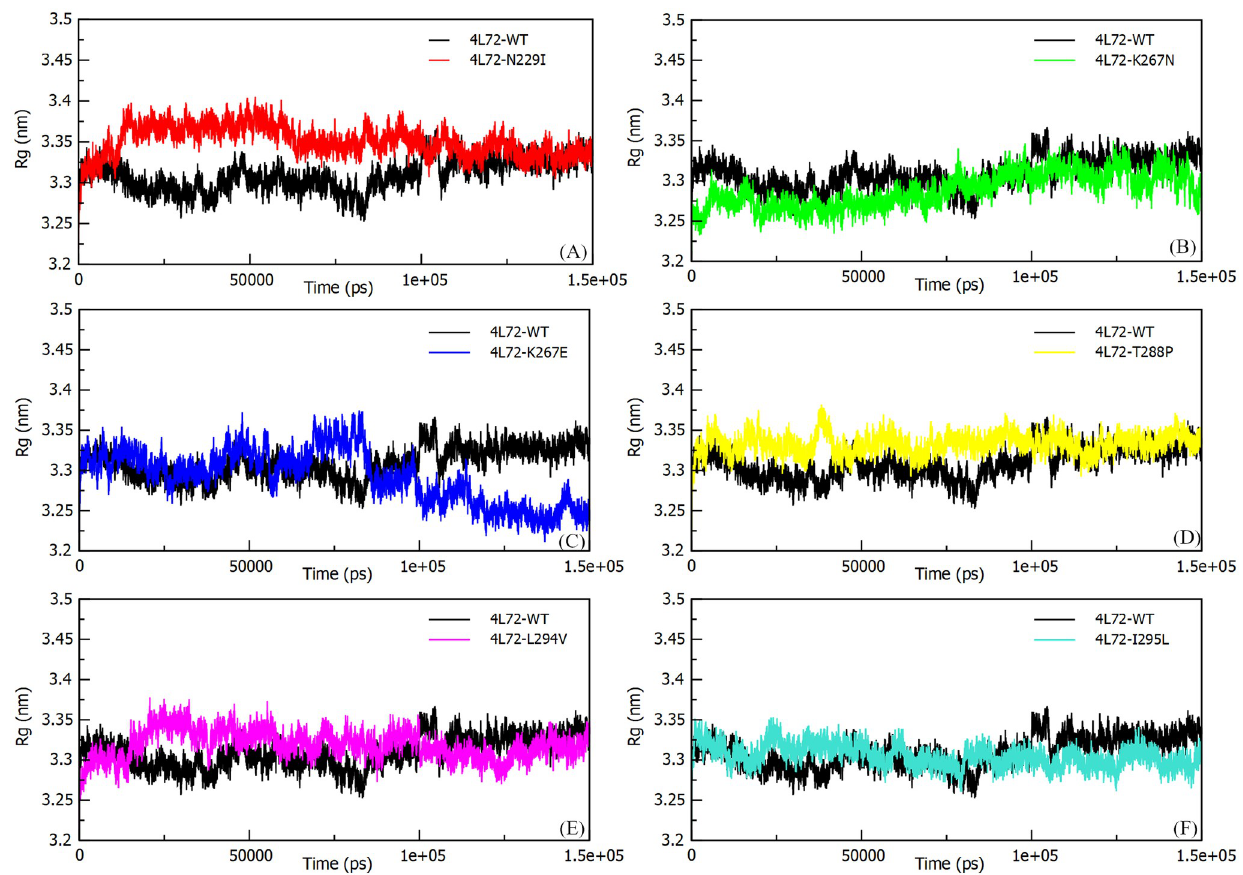
Fig 4. C α -Backbone Radius of gyration (Rg) of the human DPP4 protein in complex with MERS-CoV S1 RBD protein, during 150 ns of the molecular dynamics simulation period. (a) Rg 4L72-WT vs 4L72-N229I. (b) Rg 4L72-WT vs 4L72-K267N. (c) Rg 4L72-WT vs 4L72-K267E. (d) Rg 4L72-WT vs 4L72-T288P. (e) Rg 4L72-WT vs 4L72-L294V. (f) Rg 4L72-WT vs 4L72-I295L.